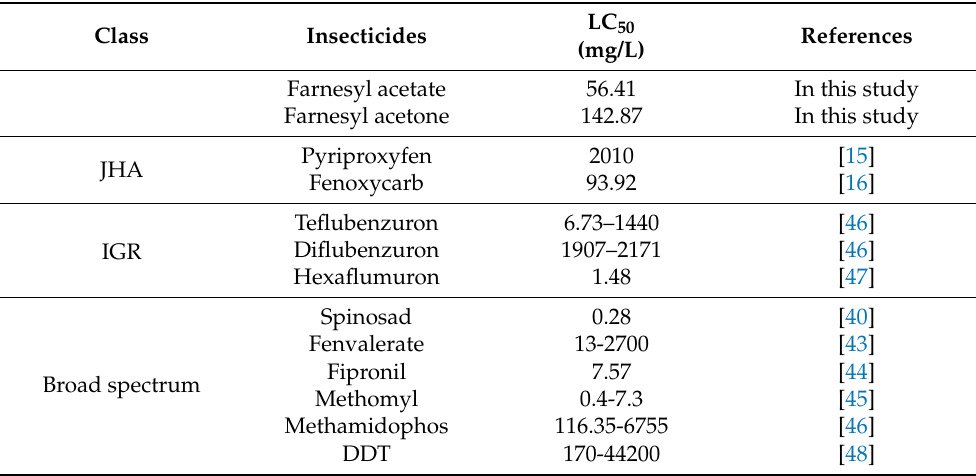
Table 6. Sublethal concentration (LC 50 ) of insecticides on P. xylostella. JHA, juvenile hormone analogue; IGR, insect growth